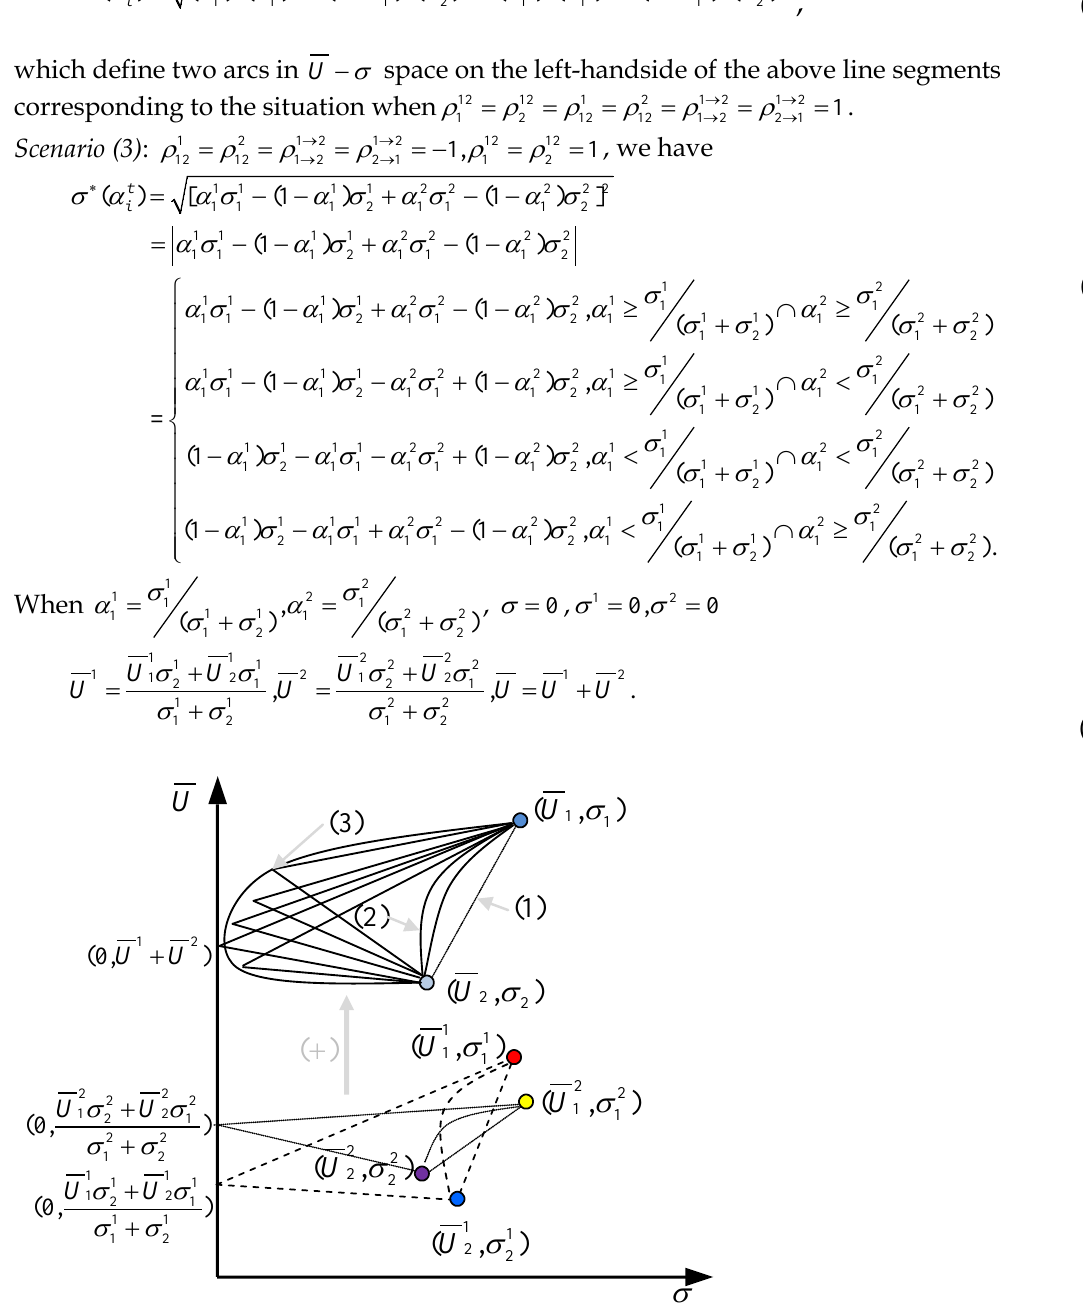
Figure 5. Feasible set of the system disutility value for two-year and two-location